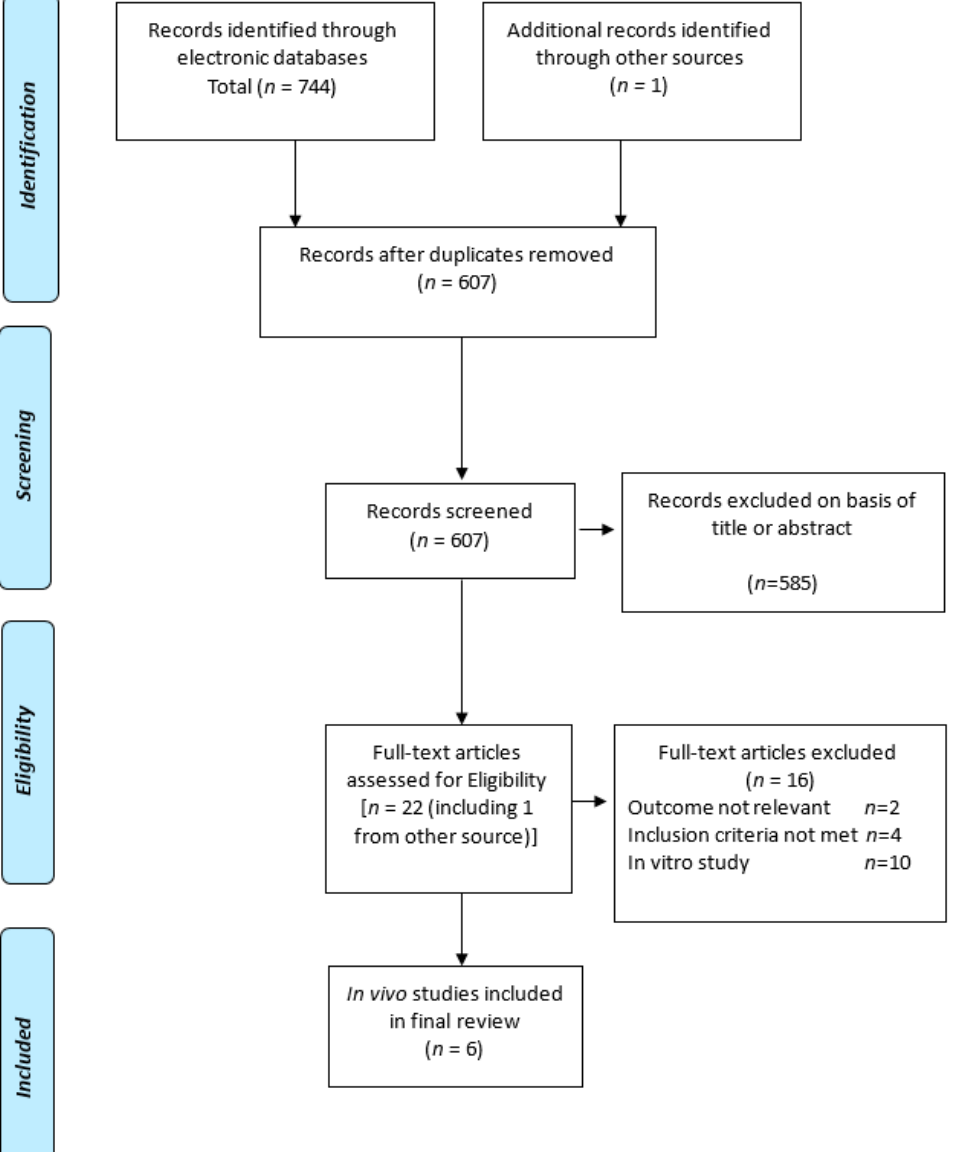
Figure 1. Preferred Reporting Items for Systematic Reviews and Meta-Analyses (PRISMA) flow chart.